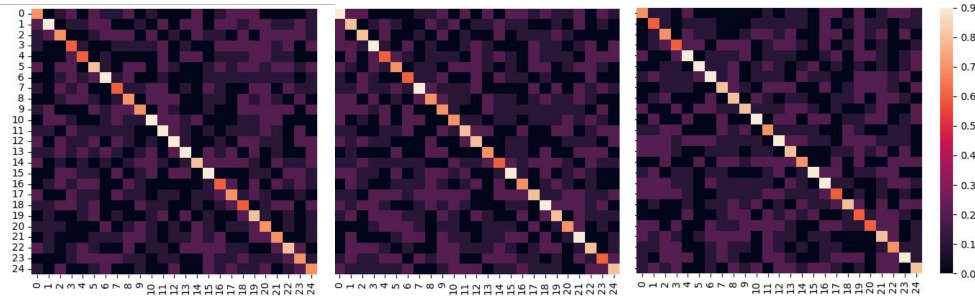
Figure 6. The affinity matrices between joints after pre-training, where the numbers represent the different joints.